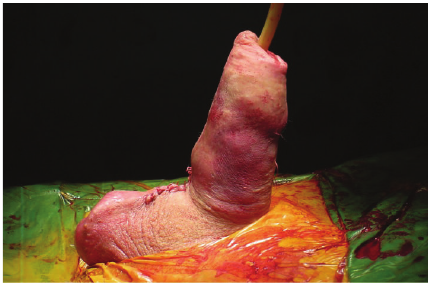
Figure 1: Artificial erection (intracavernous injection of saline and occlusion at the penile base with finger pressure) showing approximately 70 ∘ curvature of dorsal penile shaft.